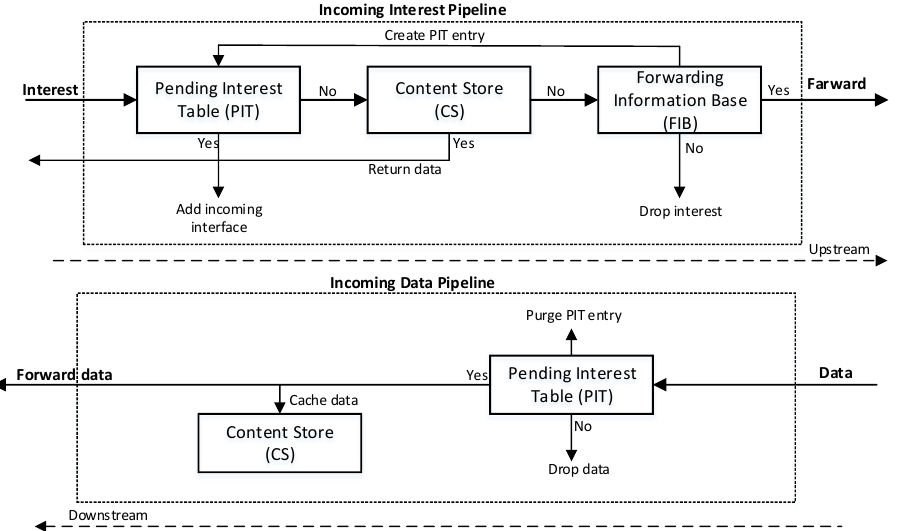
Figure 1. NDN Communication